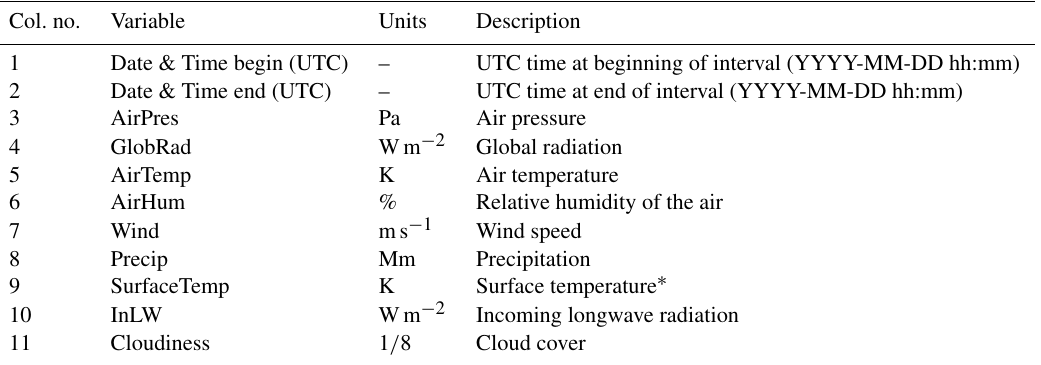
Table A7. Columns of weather data files. With the exception of the timestamps, all data types are numeric. Col.